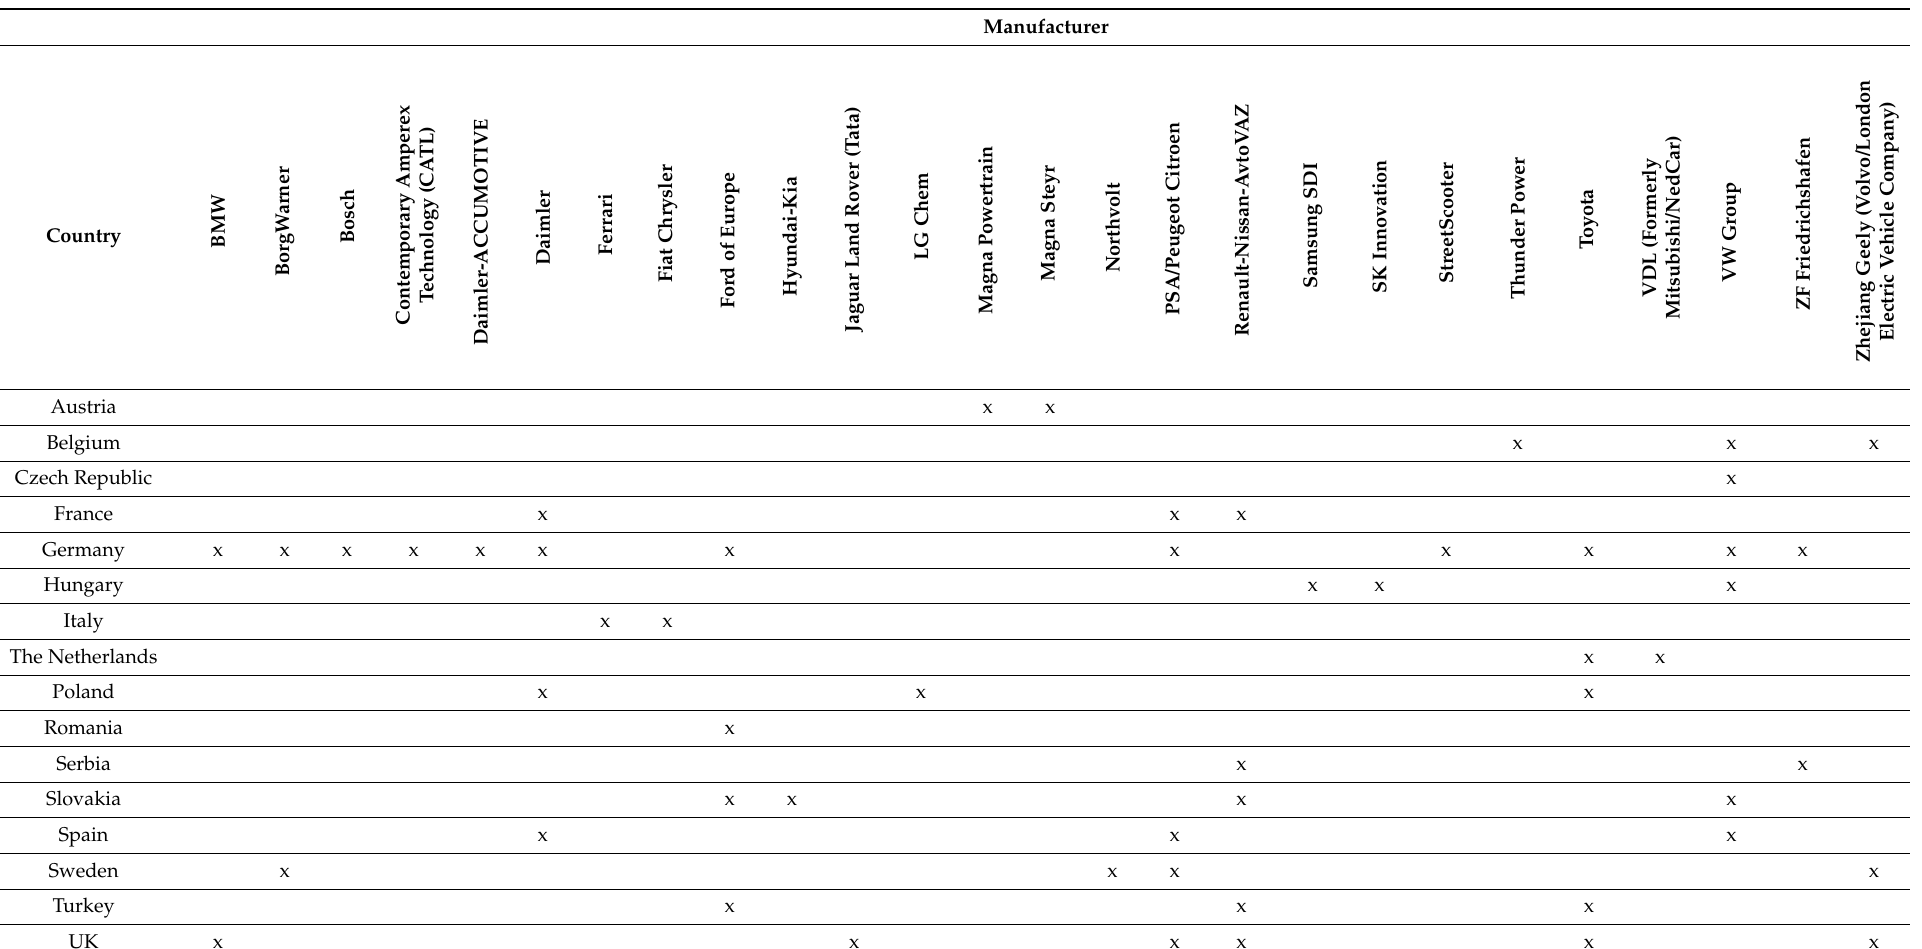
Table 1. Main electric car component manufacturers in